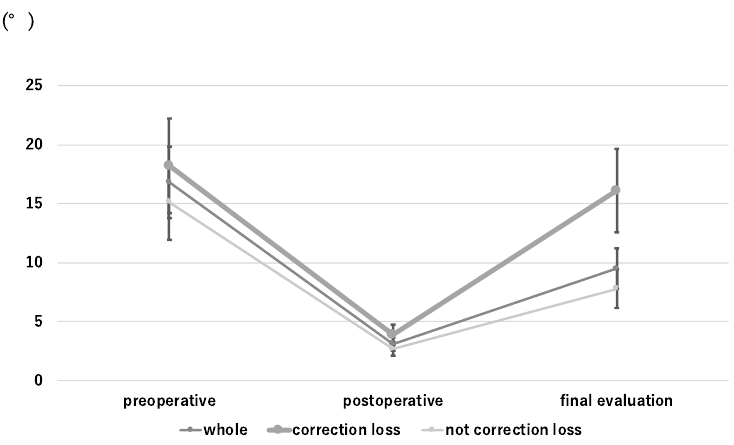
Figure 2. Change of the local kyphosis angle.